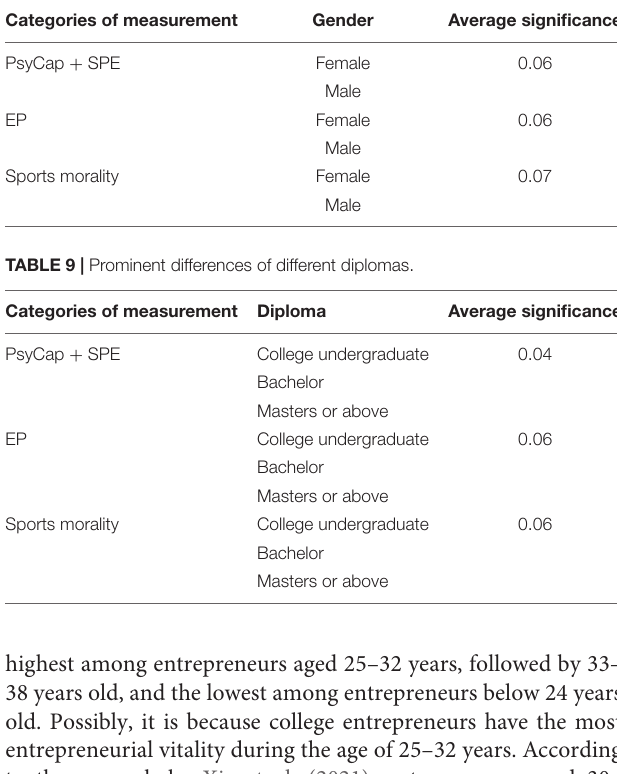
TABLE 8 | Statistical differences in gender.